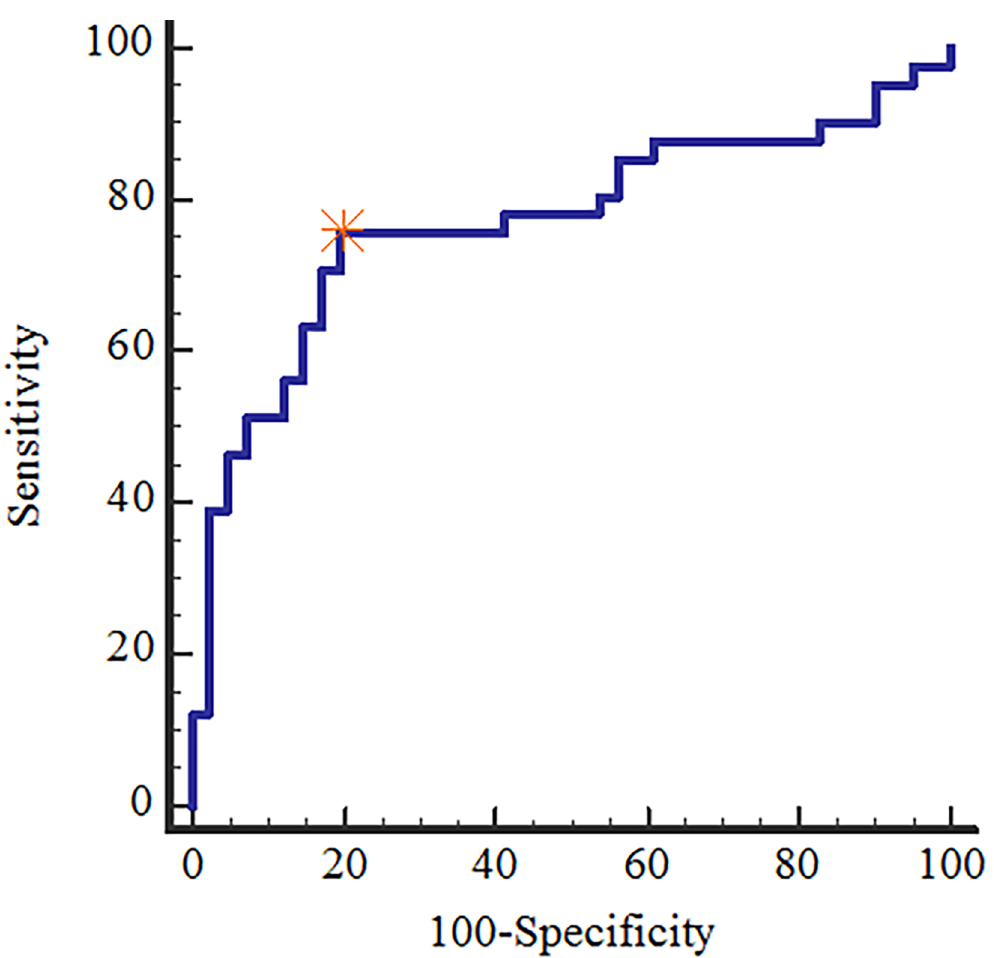
Fig 3. Receiver operating characteristic (ROC) curve for the entropy. Asterisk indicates the optimal cut off point ( > 7.141).